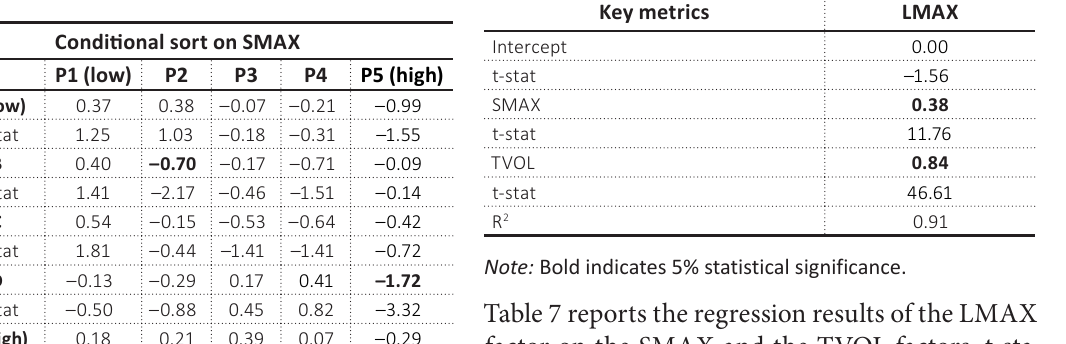
Table 6. Performance of portfolios sorted by SMax and Volatility